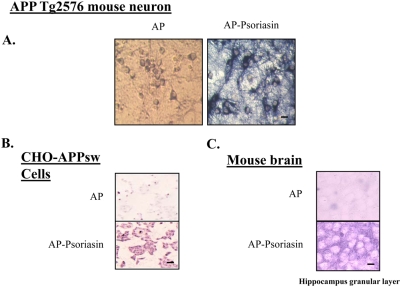
In situ S100A7 receptor binding activities in primary embryonic cortical neurons derived from Tg2576 mice, CHO-APPswe cells, and mouse brain.Seven-day-old Tg2576 neuronal cultures (A), CHO-APPswe cells (B) and 10 µm frozen tissue sections from mouse brain (C) were incubated with AP-S100A7 fusion protein or control AP protein. Blue (A) and purple (B, C) staining detects interaction between AP-S100A7 with a putative S100A7 receptor. Length bar = 10 µm. n = 3 independent cultures per group from two independent experiments.